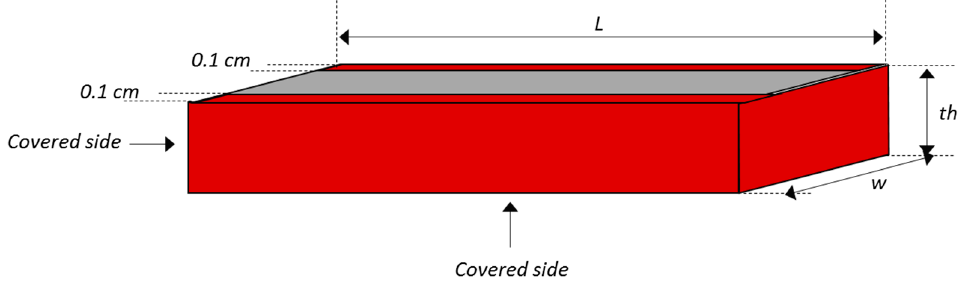
Figure 1. Scheme of the sawn mortar specimen with the side covered with an epoxy Figure 1 . Scheme of the sawn mortar specimen with the side covered with an epoxy resin.